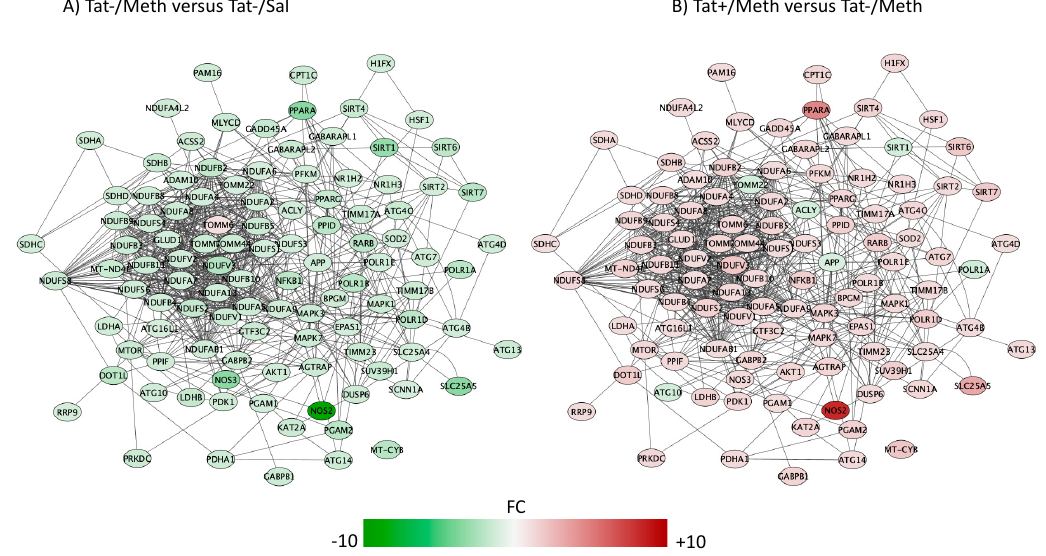
Figure 7. Sirtuin signaling pathway. Genes with overlapping actions observed in ( A ) Tat − / Meth vs. Tat − / Sal and in ( B ) Tat +/ Meth vs. Tat − / Meth and assigned to sirtuin signaling were loaded into Cytoscape via Genemania; significant changes associated to assigned comparisons ( p < 0.01) were visualized by loading the node attributes table. Tat − / Meth vs. Tat − / Sal p = 4.03 × 10 − 8 and Tat +/ Meth vs. Tat − / Meth p = 3.24 × 10 − 7 , with 50.4% and 46.4% overlap, respectively.